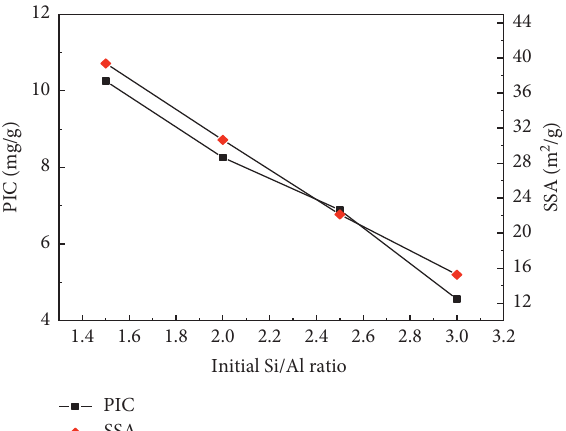
Figure 5: Changes of PIC and SSA of EMRZ synthesized under various initial Si/Al ratios (synthesis conditions: reaction temperature, 100 ° C; reaction time, 1.5h).